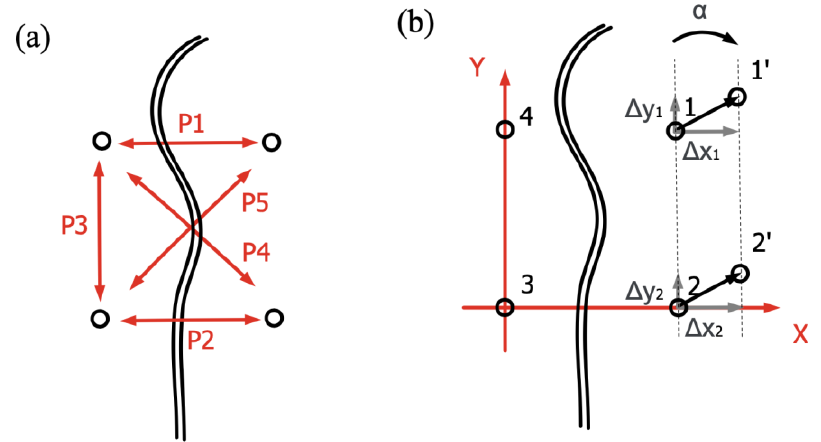
Figure 5. The SHM crackmeter measurement method (own study based on [64]): ( a ) complete analysis measurement, ( b ) coordinates calculating method.